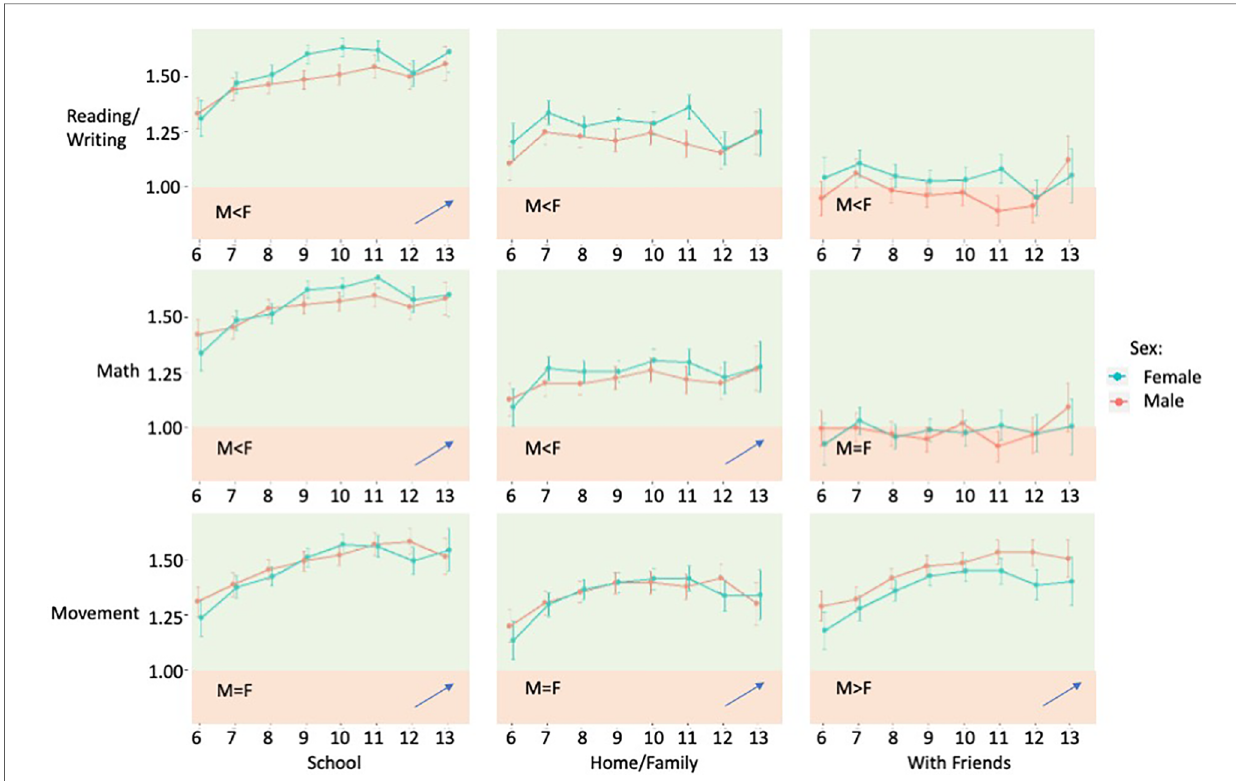
FIGURE 1 Literacy valuations (Mean, SD) in each context separated by age (bottom axis, years) and sex (M=red, F=green). Green shading corresponding to agreeable valuations, red to disagreeable. Overall sex differences for each cell indicated (W, p <0.05). Age gradients indicated by slope (blue arrow, ordinal regression with age, Kendalls